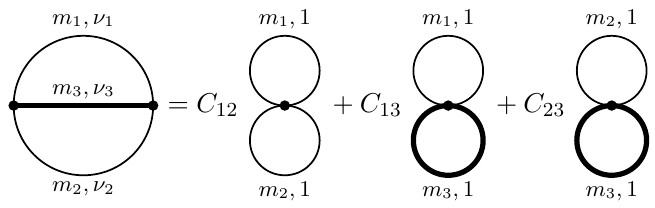
Figure 3 . Structure of the general factorization formula eq. (3.24). The C ij denote rational functions in masses m i , m j and space-time dimension d that depend on the (integer) values of the propagator powers ν k that define the two-loop integral on the left-hand side. For a special case, see figure